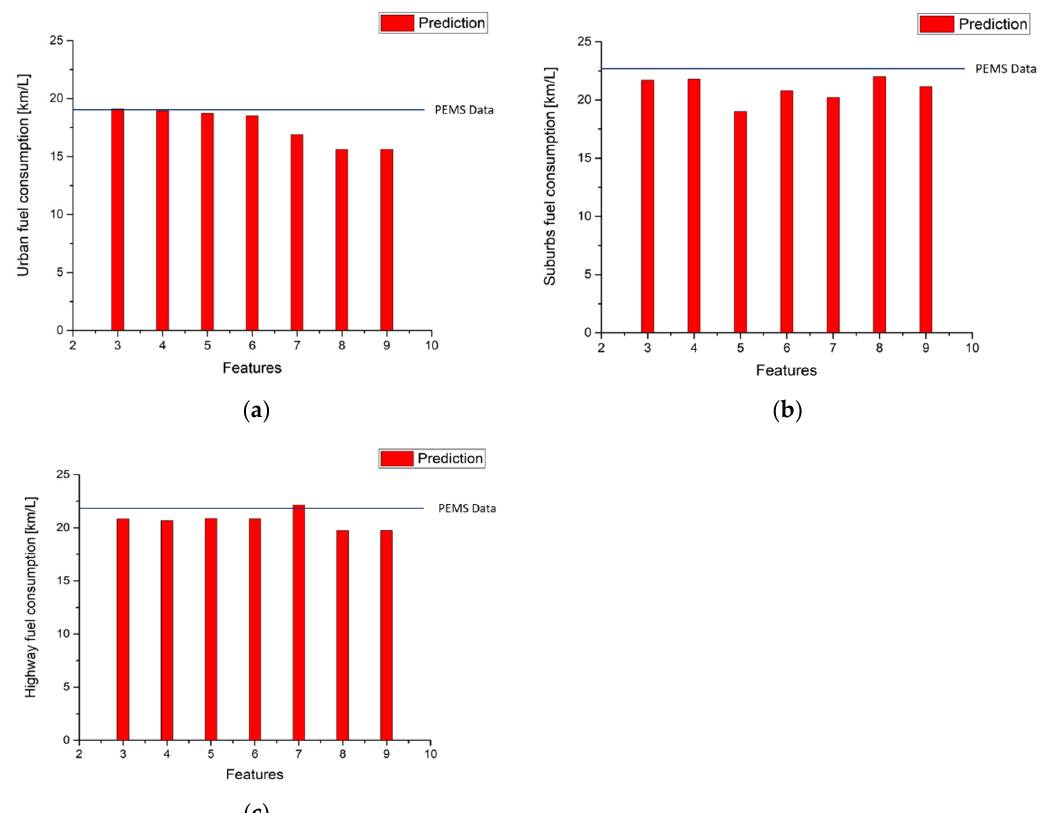
Figure 18. Second route fuel consumption predictions by using route 1 CO 2 urban model ( a ) Urban; ( b ) Suburbs; ( c ) High-